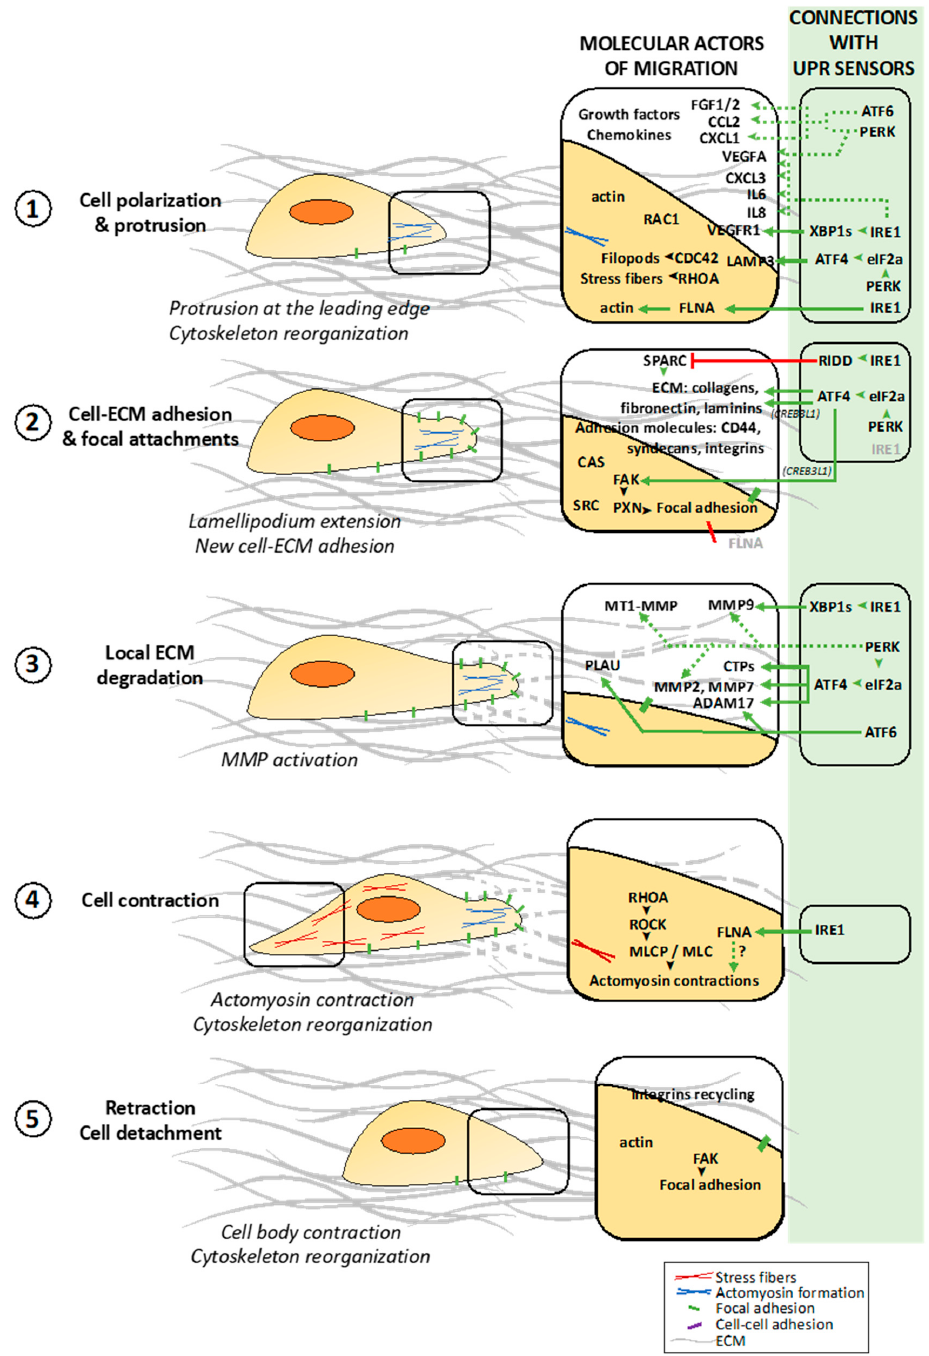
Figure 1. The cellular processes and molecular actors involved in cancer cell migration/invasion and their links to the Unfolded Protein Response (UPR) sensors. Cancer cells start to polarize via cytoskeleton reorganization at the leading edge (1) and generate new cell-matrix contacts (2). The proximal extracellular matrix (ECM) surrounding the leading edge is degraded by metalloproteinases (MMPs) activation